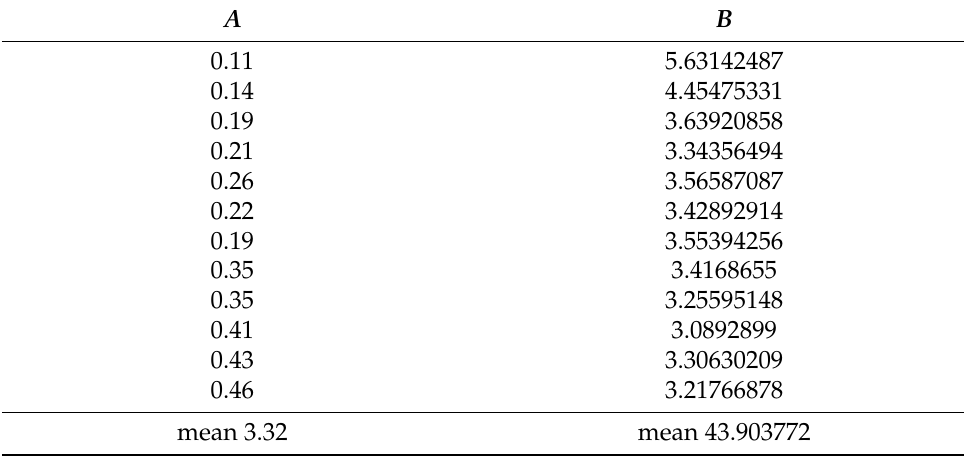
Table 2. Estimation of the parameters A and B